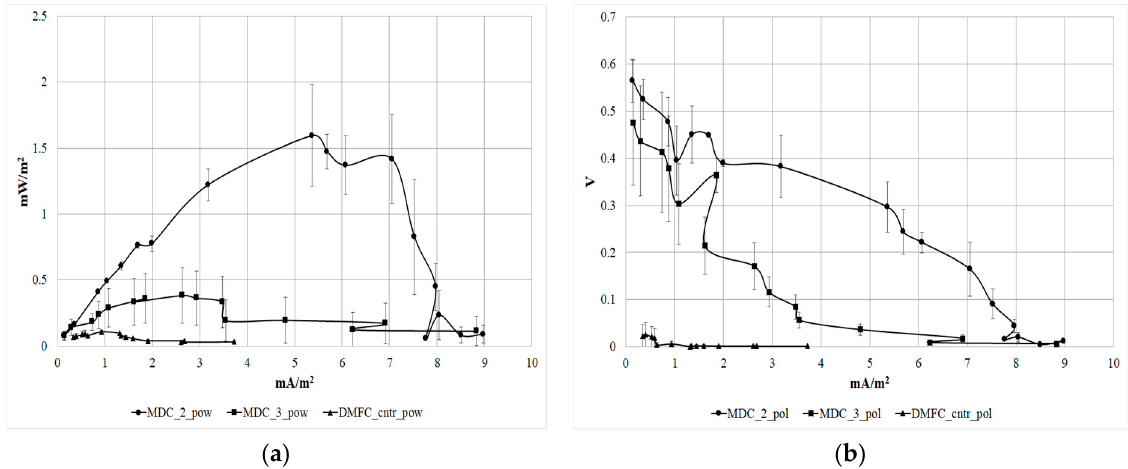
Figure 3. Power ( a ) and polarization ( b ) curves obtained by interpolating average values of PD, CD, and V ± Standard Error.